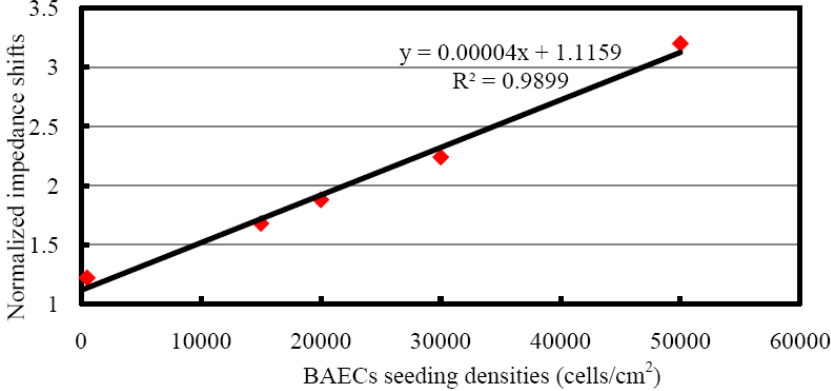
Figure 11. Linear relation between normalized impedance values coresponding to and different BAECs seeding